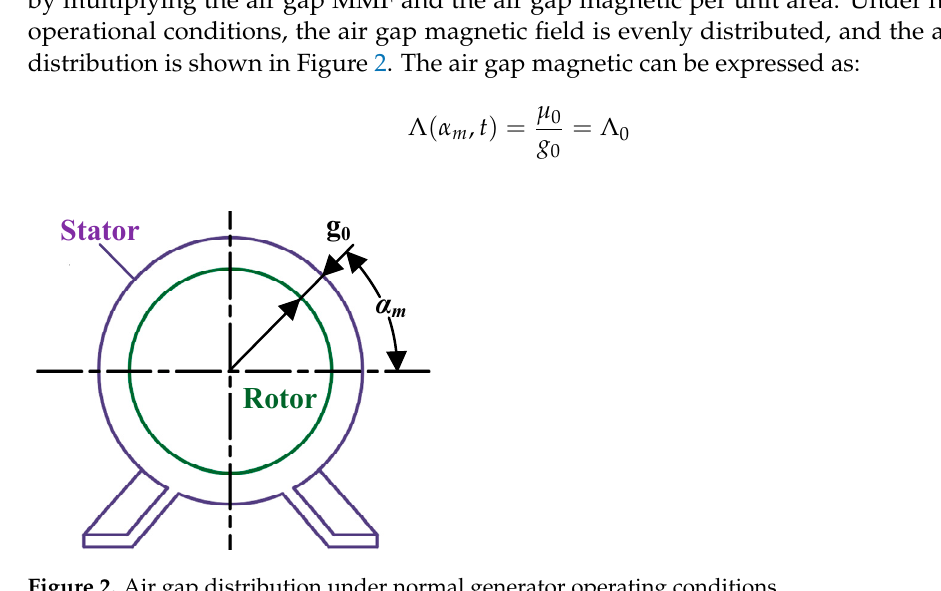
Figure 1. Response maps of the pulses and steps.